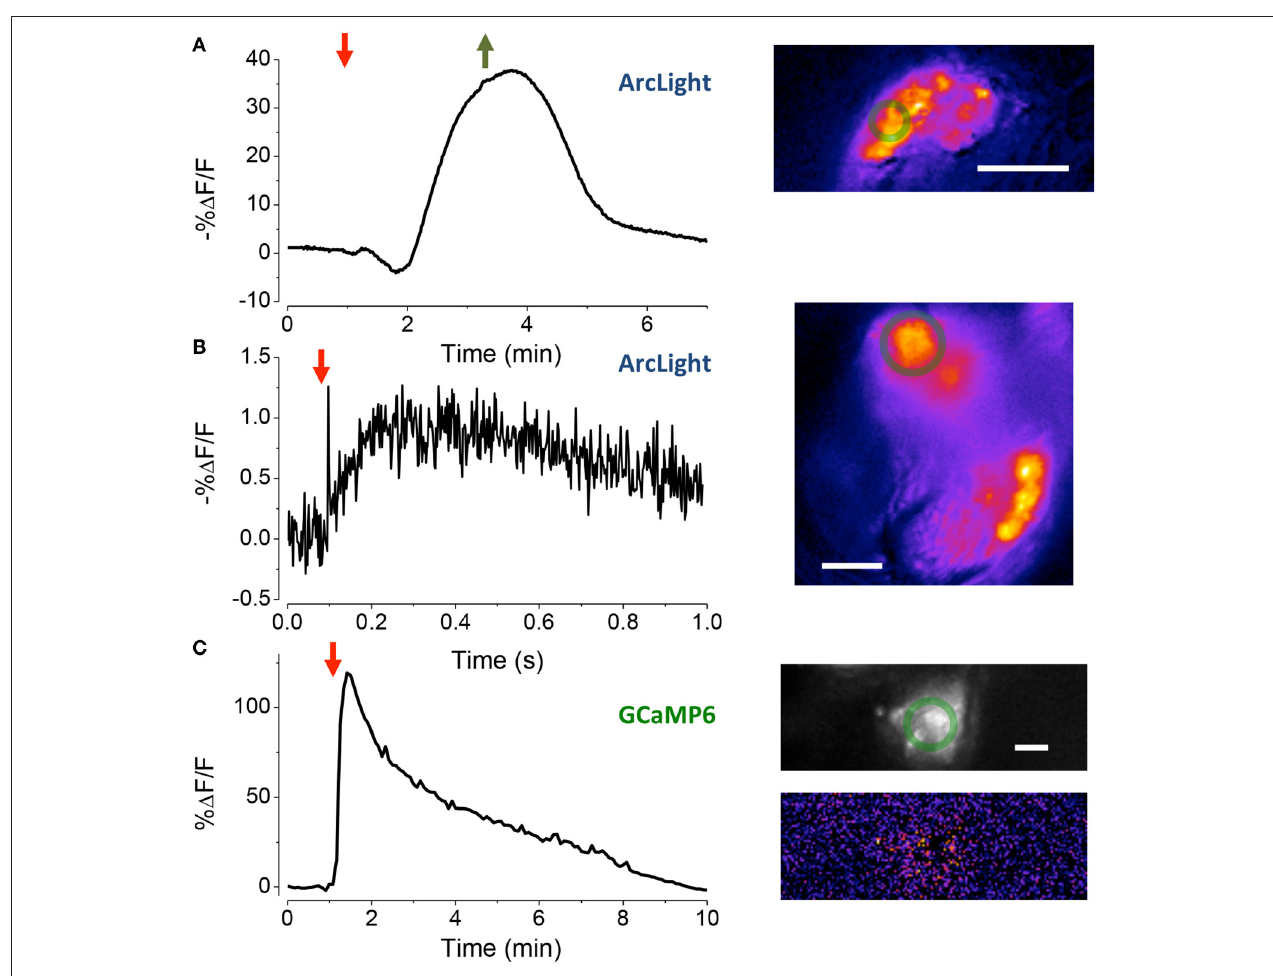
FIGURE 4 | Assessing the vitality of exposed JOs. (A) Response of sensory cells in JO expressing ArcLight to the perfusion of HiK (red arrow) and restoration of normal saline (green arrow). Inset, pseudo-color image of difference between the image prior to stimulation and at its peak. Scale bar 20 µ m. The green circles are the regions-of-interest used to produce the time traces. (B) Local electrical stimulation (arrow, 200 µ s, 0.1mA) of sensory cells in JO expressing ArcLight. Scale bar 10 µ m. (C) Response of JO expressing GCaMP6 to application of pymetrozine (arrow, 3.4 µ M). Top inset fluorescence, bottom inset pseudo-color difference image. Scale bar 20 µ